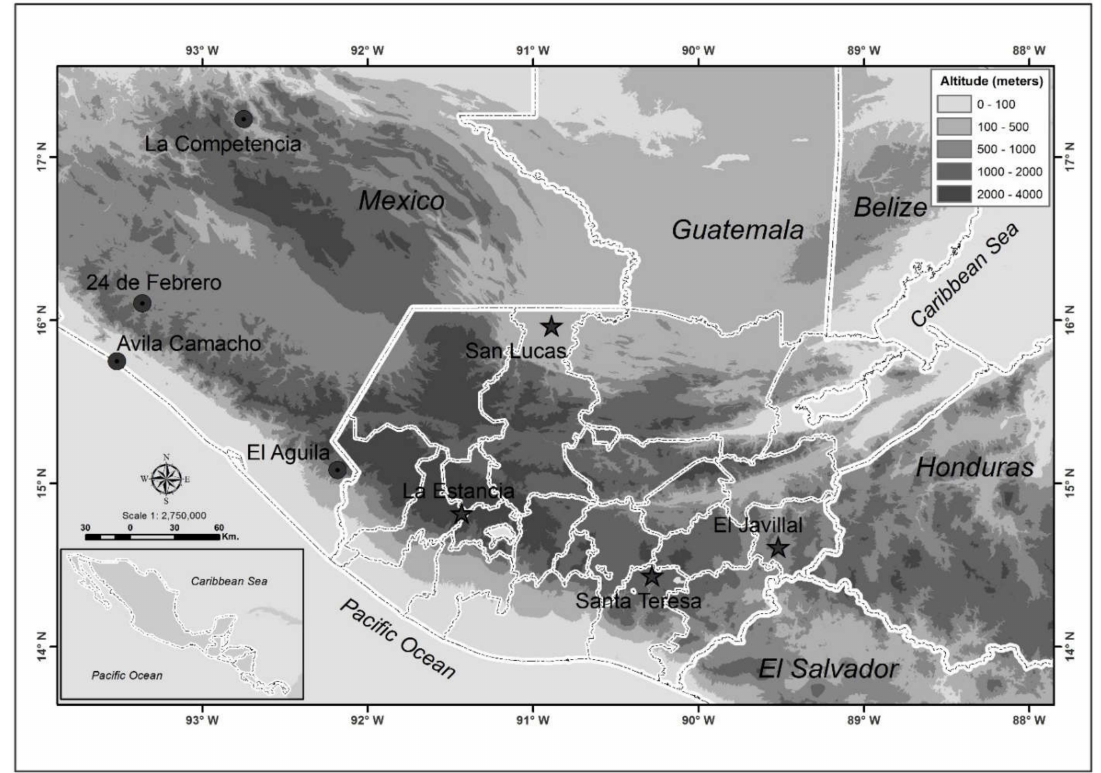
Figure 2. Map of the study area and the eight communities in the